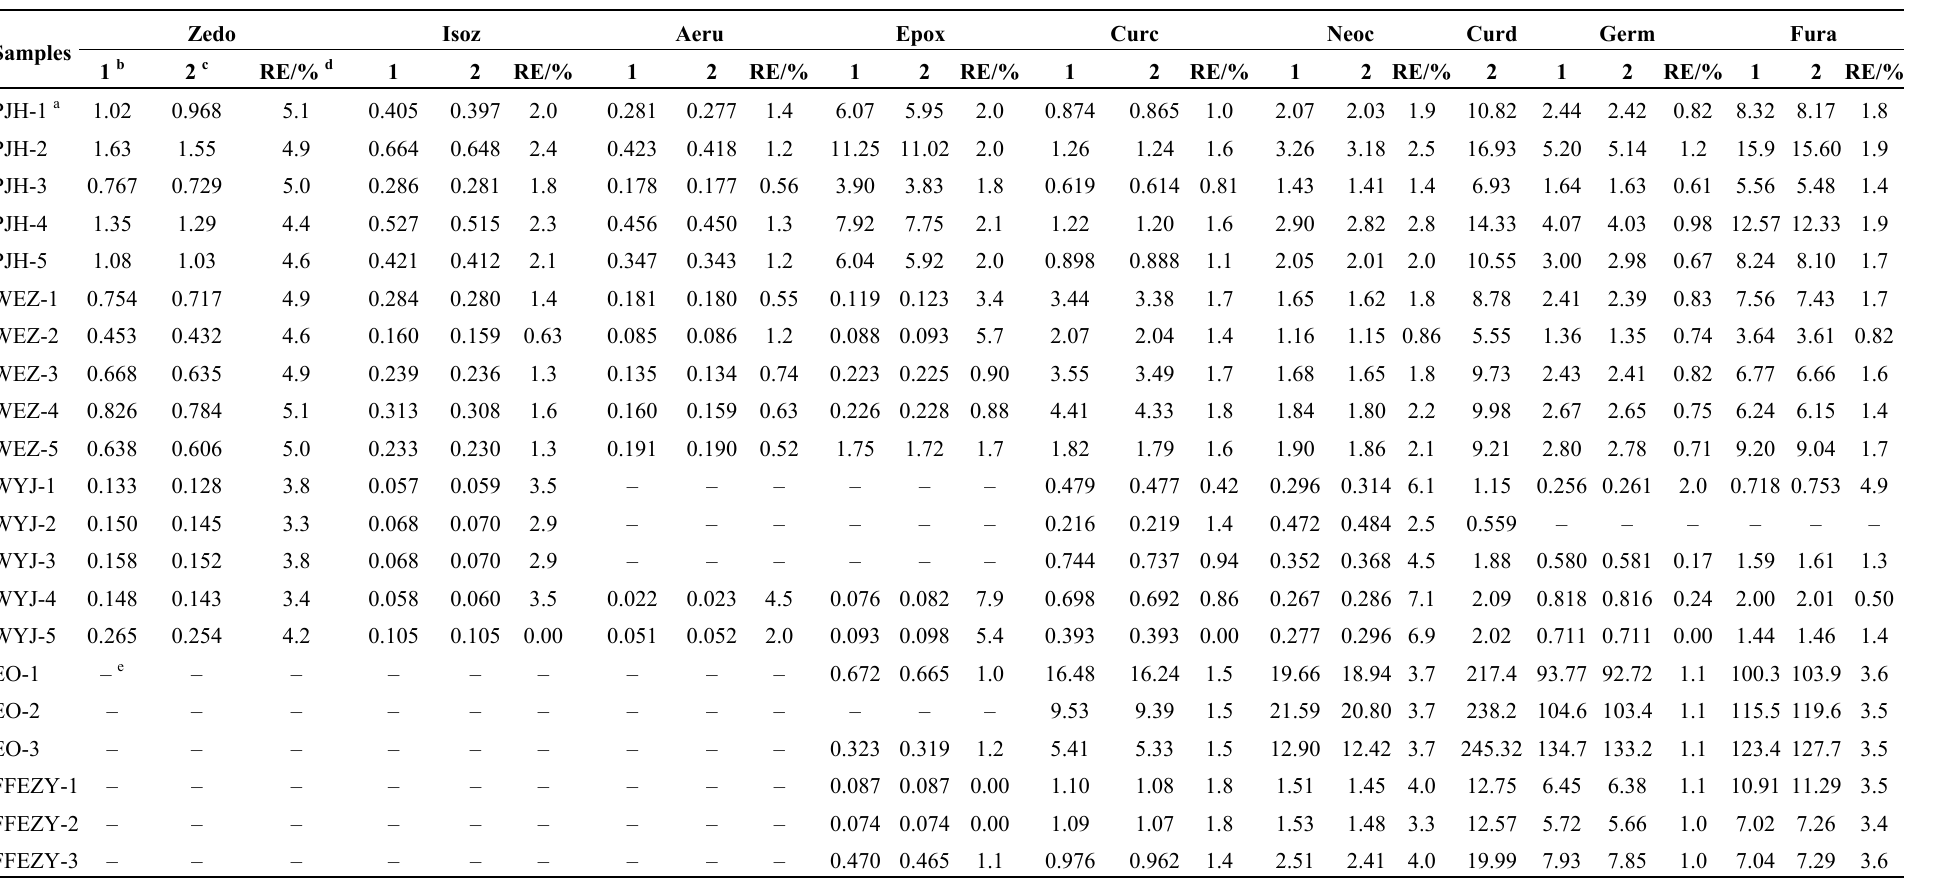
Table 6. Comparison of sesquiterpenes contents in Curcuma samples determined by two methods (mg·g − 1 , n =